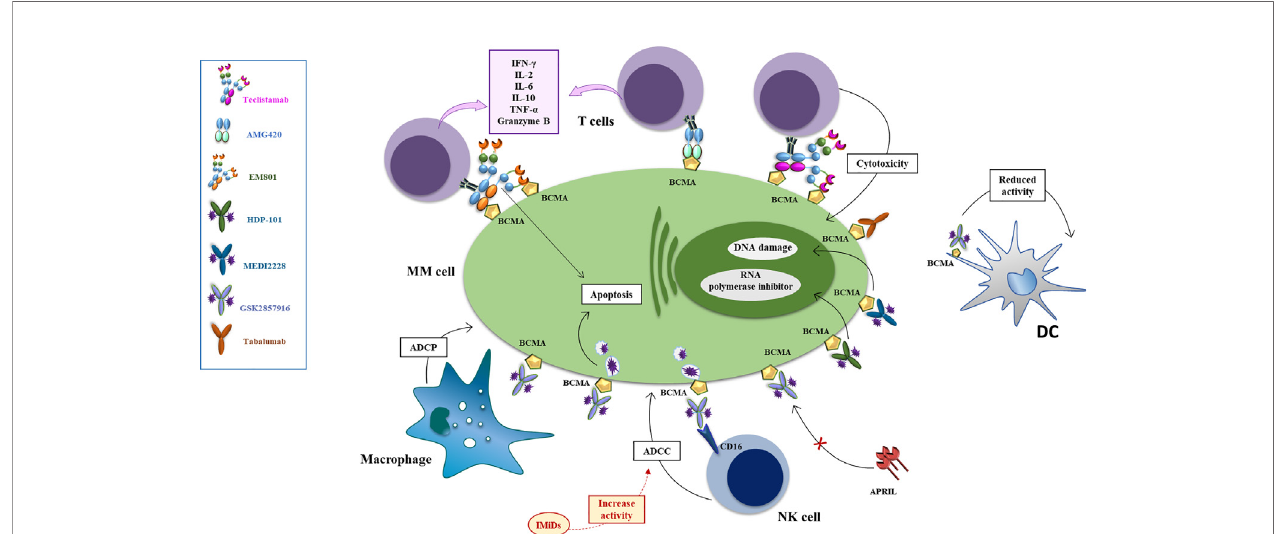
FIGURE 3 | Mechanisms of action of anti-BCMA mAb, antibody drug conjugates and bispeci fi c antibodies. The antibody drug conjugate Belantamab mafodotin exerts anti-MM effect via several mechanisms: i. inducing ADCP via binding of the defucosylated Fc fragment of macrophages the arrest of MM cells in G2/M phase resulting in apoptosis; ii. inducing a powerful ADCC via binding of the defucosylated Fc fragment of NK and PBMC cells (an effect enhanced by combination with lenalidomide) iii. competing with BAFF and APRIL, reducing their signal of activation of NFkB in MM cells (an effect enhanced by combination with bortezomib) iv. reducing activity of BCMA+dendritic plasmacytoid cells which support proliferation and drug resistance of MM cells. Upon binding with MM cells via BCMA, MEDI2228 releases pyrrolobenzodiazepine to promote DNA damage and cell death, while HDP-101 releases the RNA polymerase inhibitor amanitin, to reduce transcription and protein synthesis, resulting in apoptosis of both rapidly dividing and resting cells. AMG 224 is an antihuman BCMA IgG1 antibody conjugated with mertansine, to inhibit the assembly of microtubules with consequent cell death. Tabalumab (LY 2127399) is an-anti BAFF human naked monoclonal antibody that neutralizes the membrane-bound and soluble forms of this factor, reducing their signal of activation of NFkB in MM cells. Bispeci fi c monoclonal antibodies can simultaneously bind to two different types of antigen to engage effector cells against neoplastic cells. EM-801 and AMG-420 are two examples of BCMA/CD3 bispeci fi c T-cell engager. Teclistamab is a BCMA/CD3